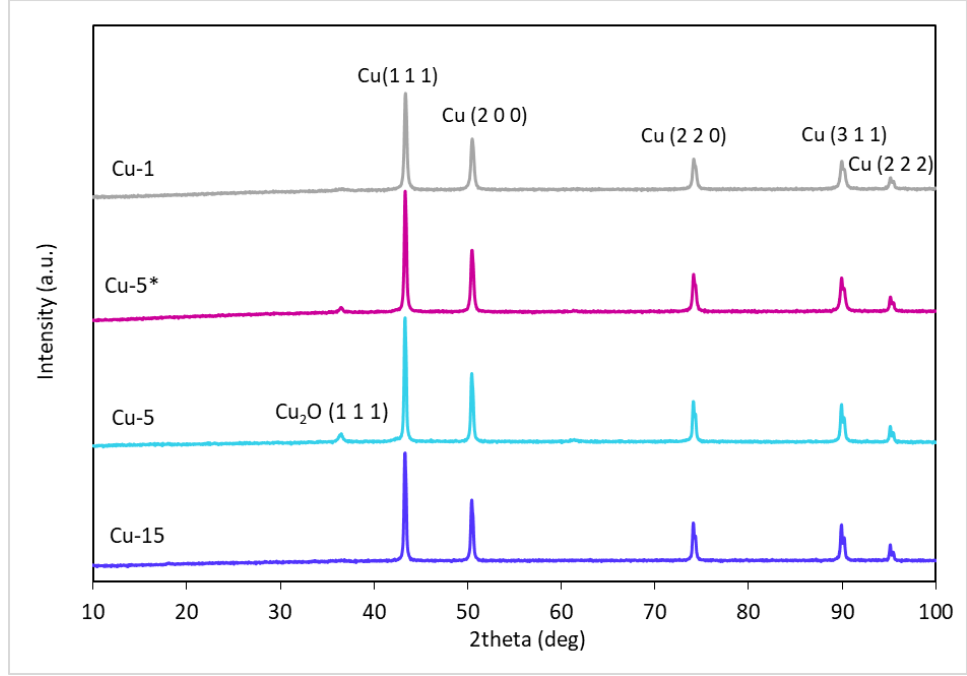
Figure 7. The XRD patterns of copper catalysts (Cu-1, Cu-5*, Cu-5, Cu-15) generated in situ in the reaction medium during hydrogenolysis of glycerol.